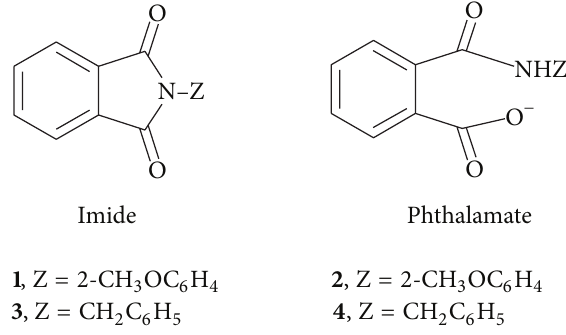
Figure 1: Molecular structures of compounds 1 , 2 , 3 and 4 .